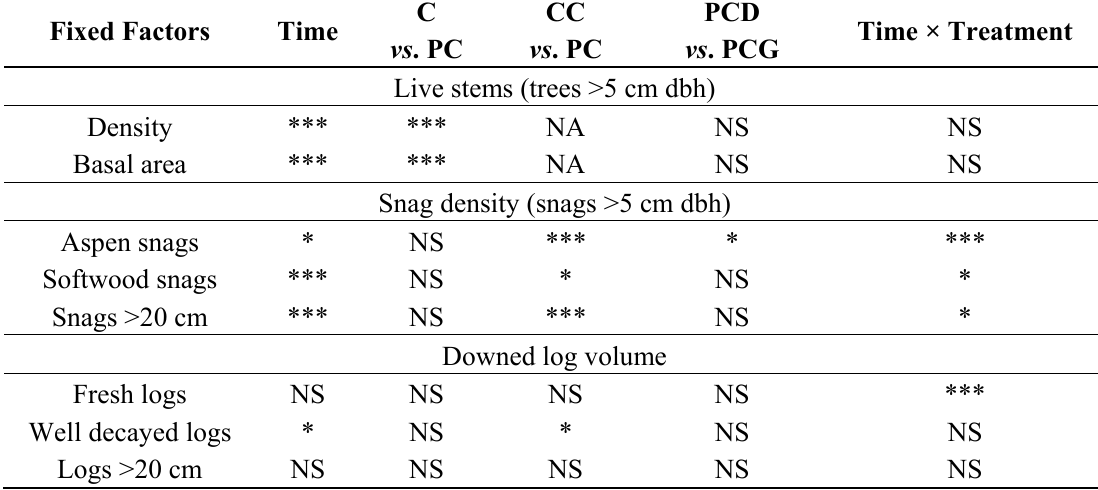
Table 1. Effects of complete and partial harvesting and time since harvesting on boreal mixed stands characteristics. Significance of fixed effects is based on the Type 1 test of